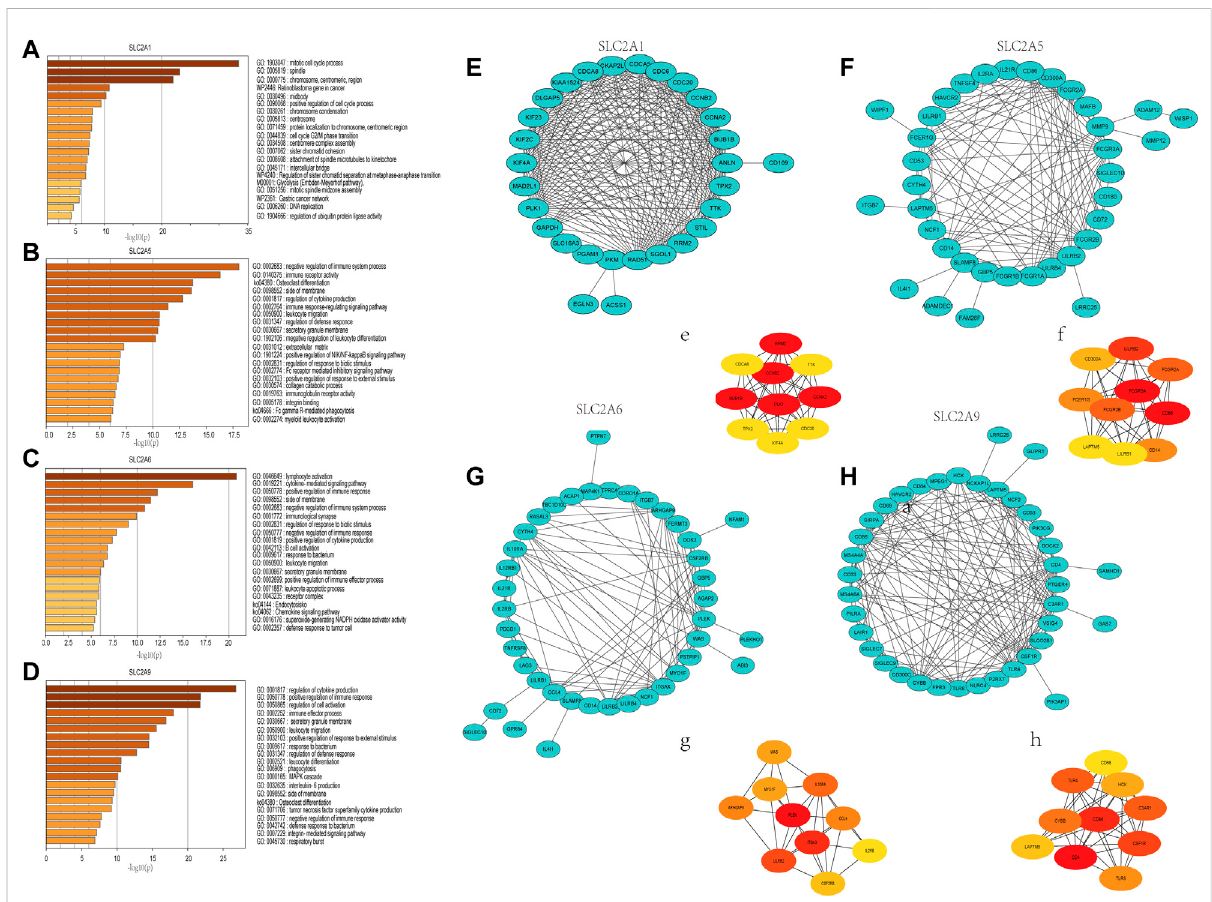
FIGURE 7 Gene Ontology (GO) annotations and Kyoto Encyclopedia of Genes and Genomes (KEGG) pathway analyses of genes that ranked top 100 co- expressed genes with SLC2A1 , SLC2A5 , SLC2A6 , SLC2A9 . (A) SLC2A1 . (B) SLC2A5 . (C) SLC2A6 . (D) SLC2A9 . Construction of an interaction network with SLC2As top 100 correlated genes and identi fi cation of potential hub genes. (E – H) PPI network of SLC2A1 , SLC2A5 , SLC2A6 , and SLC2A9 co- expressed genes. (e – h) The top 10 hub genes identi fi ed in the PPI